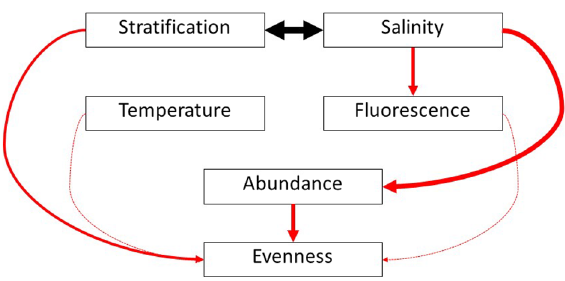
Figure 4. Structural Equation Model (PSEM) of zooplankton abundance and evenness in the northwestern GOM. Red arrows indicate negative relationships between parameters, while black hollow-headed arrows represent positive. Relative size of the arrow width indicates magnitude of the interaction. Dotted lines indicate cases in which there was a non-significant main effect of the predictor on the response variable, but the predictor interacted with “Harvey” to affect the response variable.